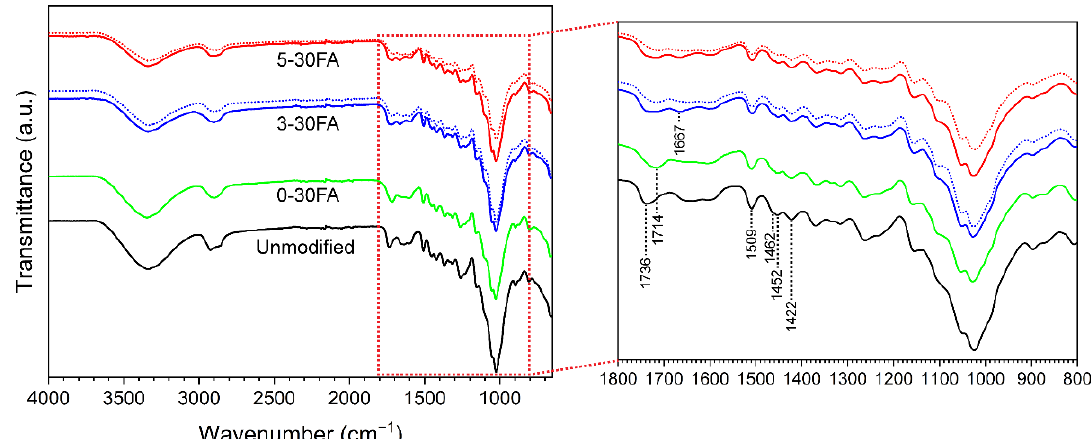
Figure 7. FTIR spectra of the unmodified specimen and 0-30FA, 3-30FA, and 5-30FA modified specimens. The solid curves represent pre − leaching, while the dotted curves represent post − leaching.